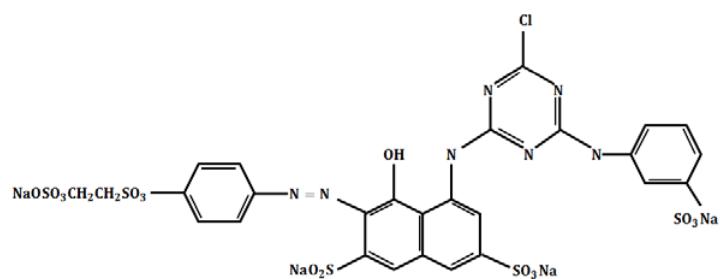
Fig. 1: Molecular structure of reactive red dye